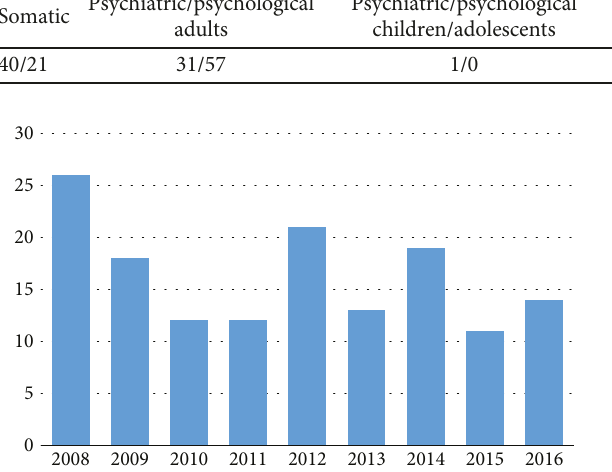
Figure 1: Frequency of ICD-10 diagnosis code F68.1 per year from 2008 to 2016 in 146